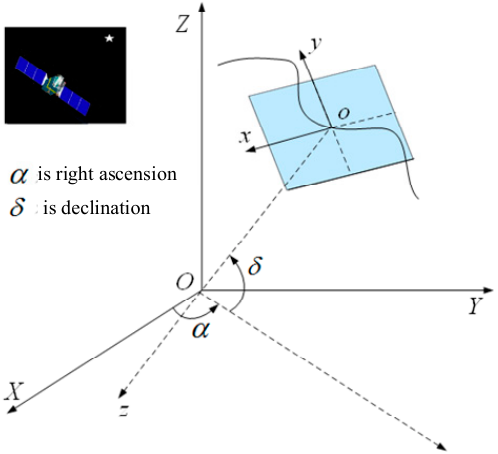
Figure 3. Diagram of satellite microvibration detection based on star map.